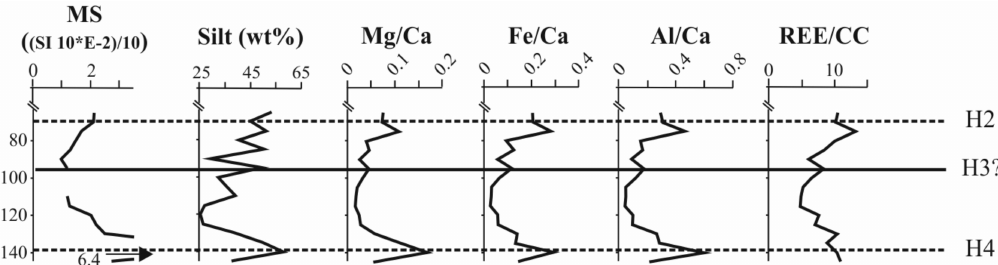
Figure 9. A detailed range of depth profiles for the ratios studied in + 57-20 / 9 (see Figure 5), showing a possible H3 signal (solid line). H2 and H4 are marked with dashed